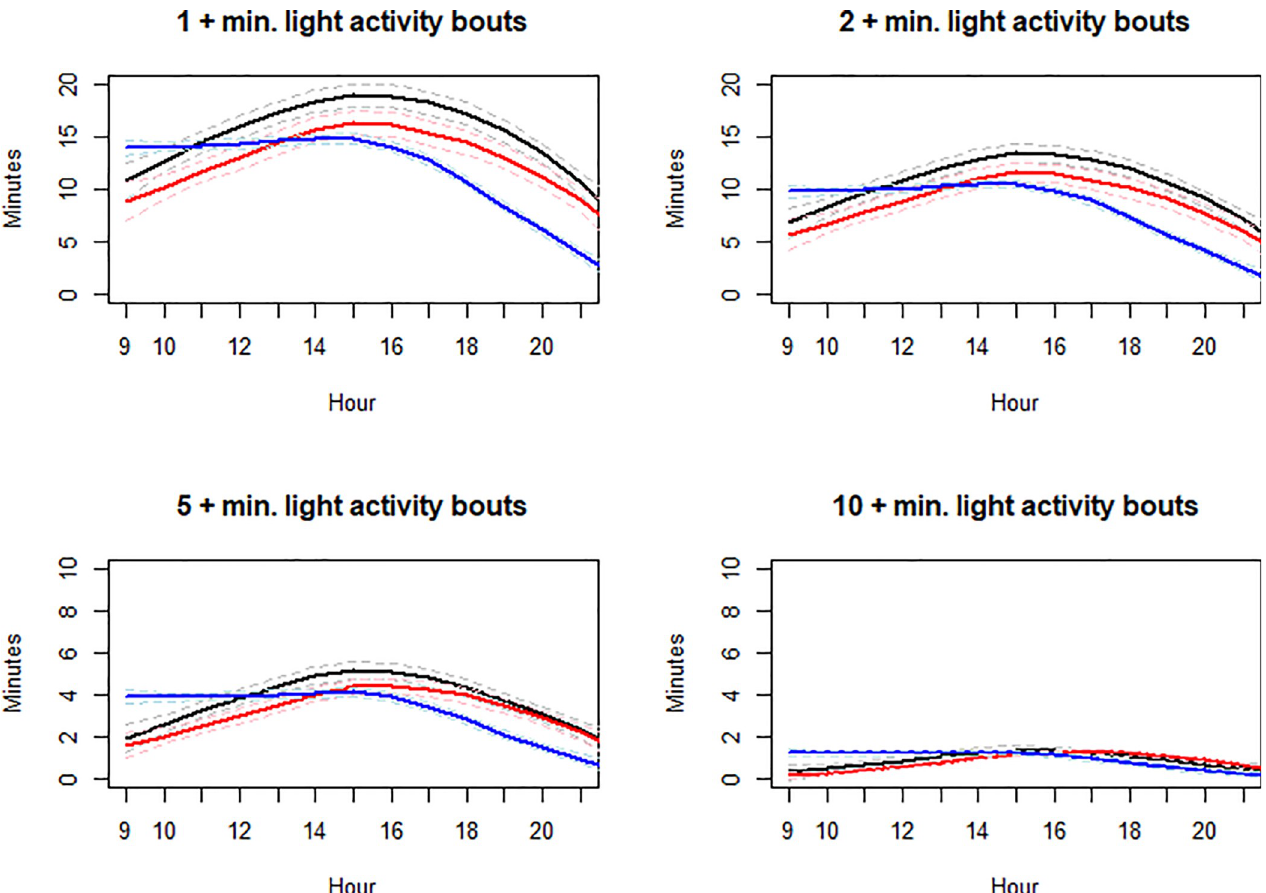
Fig 2. Mean light PA minutes by bouts in different lengths for each hour between 9am and 9 pm: Age 14 (black), Age 17 (red), Age 23 (blue). Dashed lines represent the 95% confidence band.